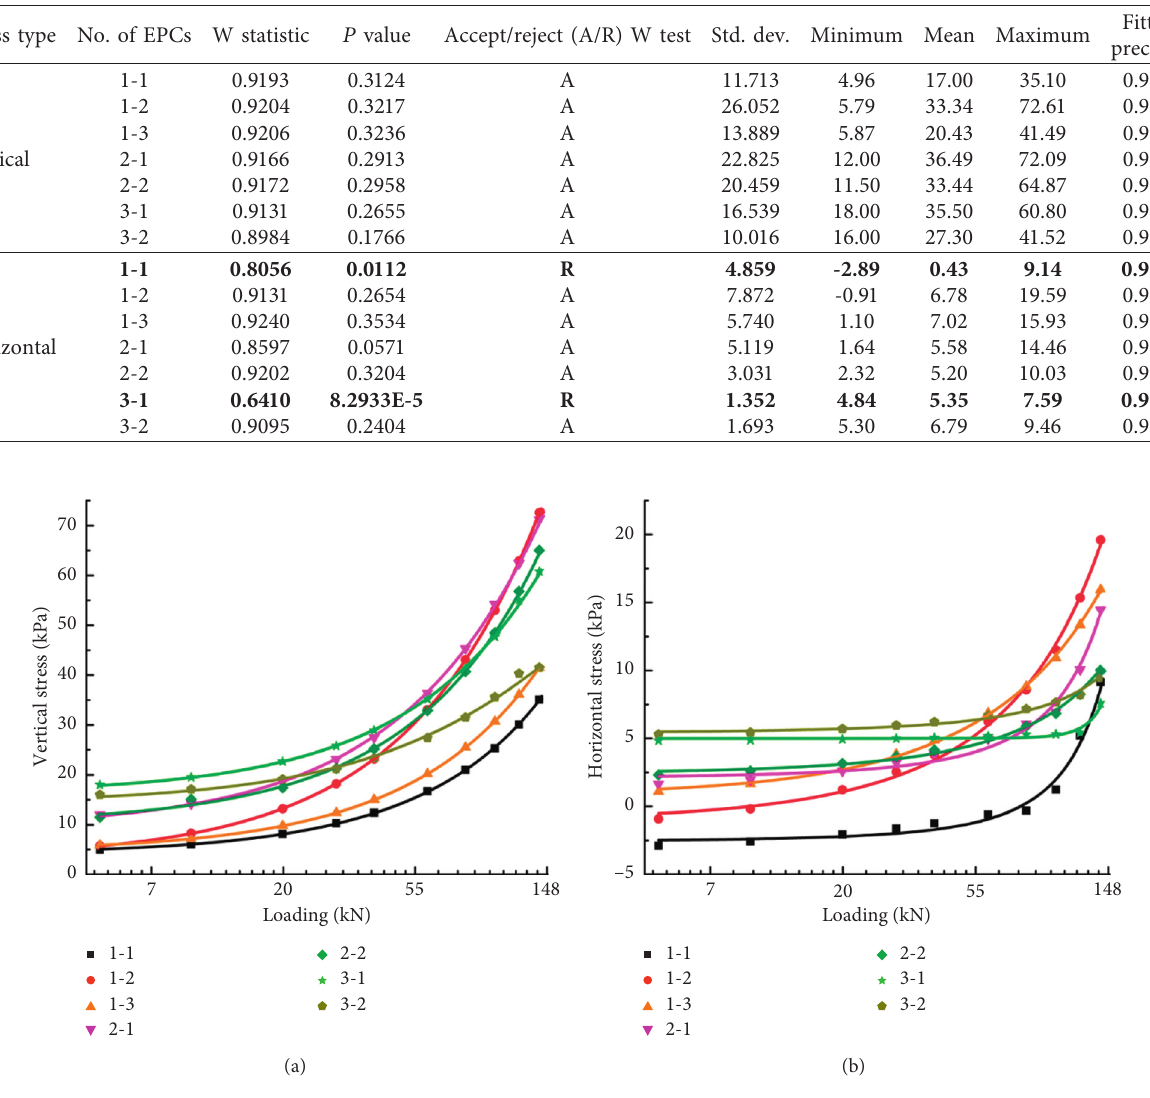
Figure 5: Relationship between the qualified stresses and loading in the loading zone. (a) Vertical stress. (b) Horizontal